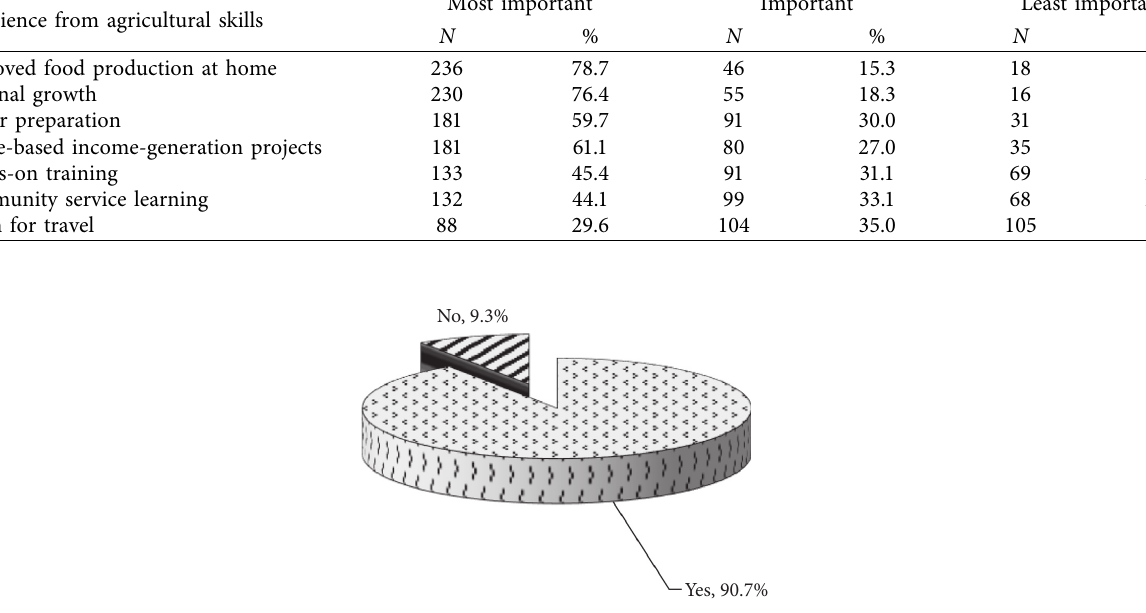
Figure 6: Percentage proportion of the parents’ opinions for their children to do agriculture as an elective subject. Table 6: Parents’ opinions on the frequency of the use of the skills developed for food